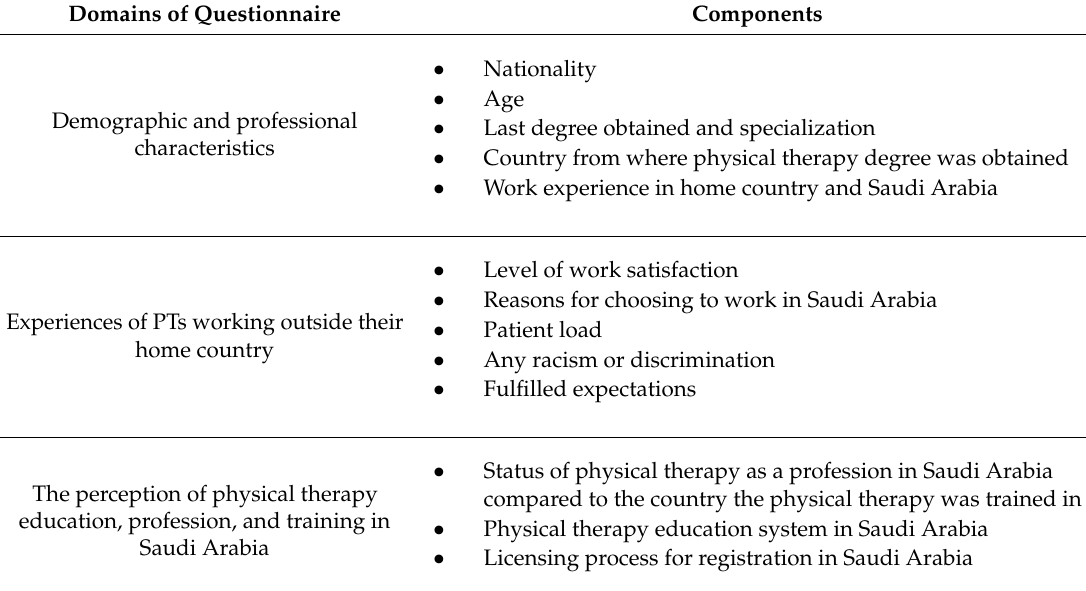
Table 1. A questionnaire consisting of 30 items was divided into three